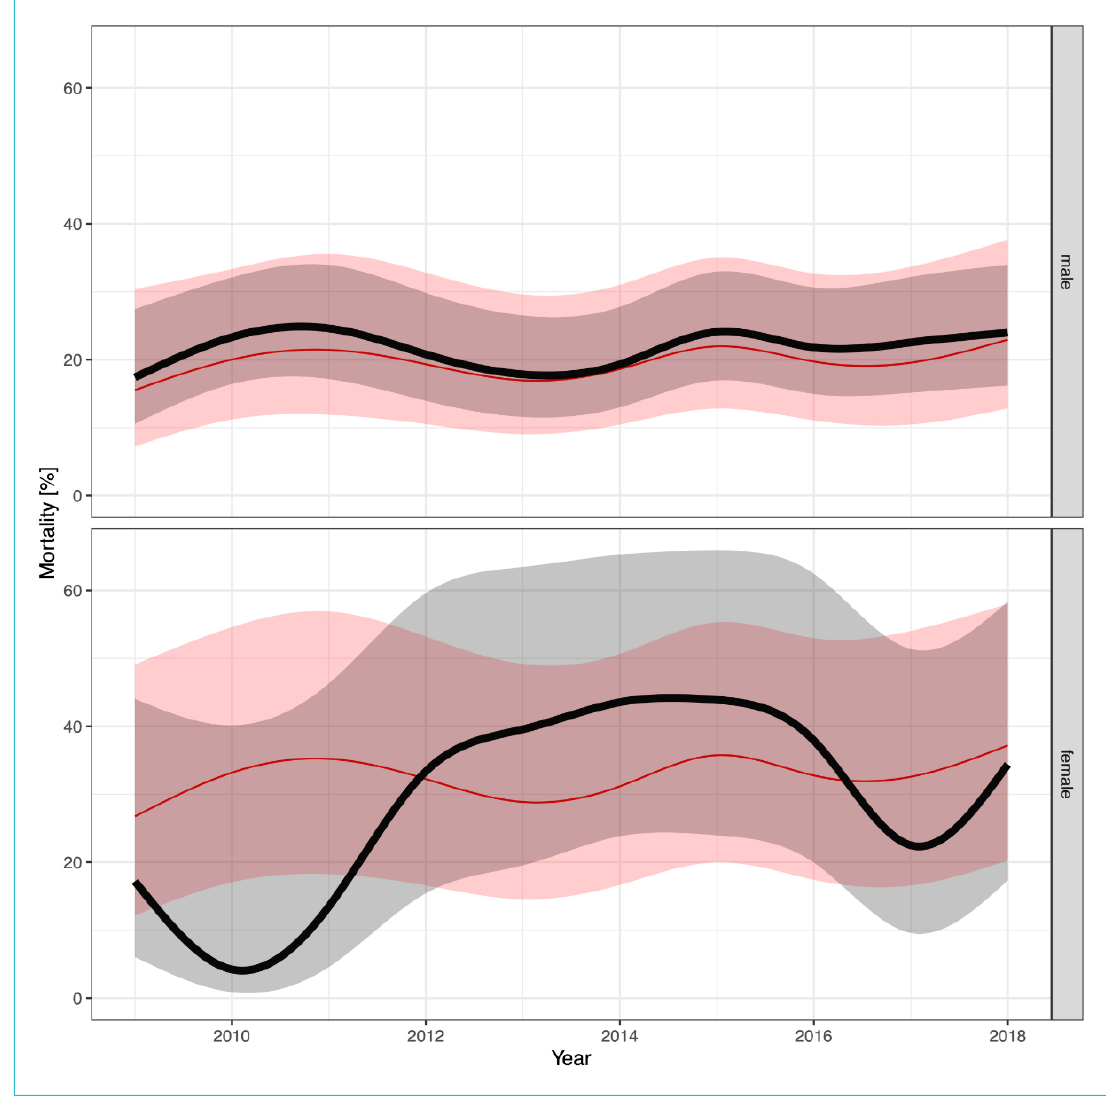
Figure 5: Hospital mortality of patients treated for ruptured abdominal aortic aneurysm. Smoothed hospital mortality rates of patients treated for ruptured abdominal aortic aneurysms stratified by sex. The solid black line shows the raw mortality rate, the grey area shows the corre- sponding 95% confidence interval. The red line shows the mortality rate adjusted for age, sex, year of treatment, van Walraven